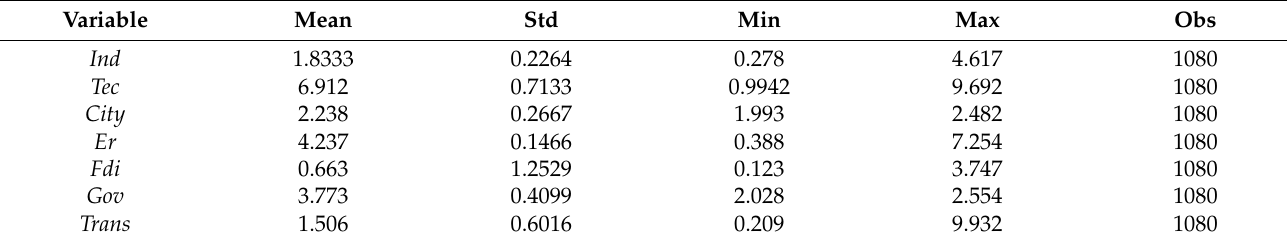
Table 3. Control variables and their descriptive